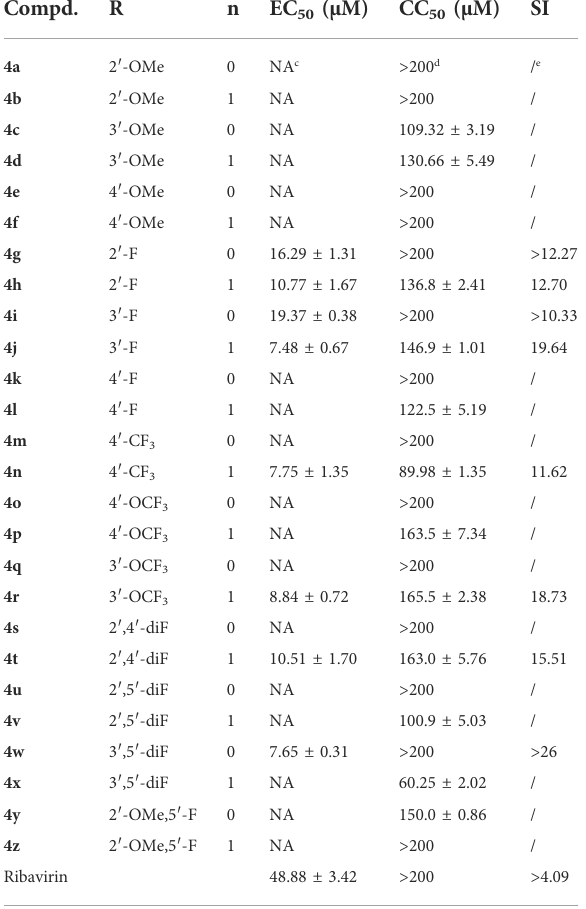
TABLE 1 Structures, EC 50 a , CC 50 b , and SI of titled compounds.